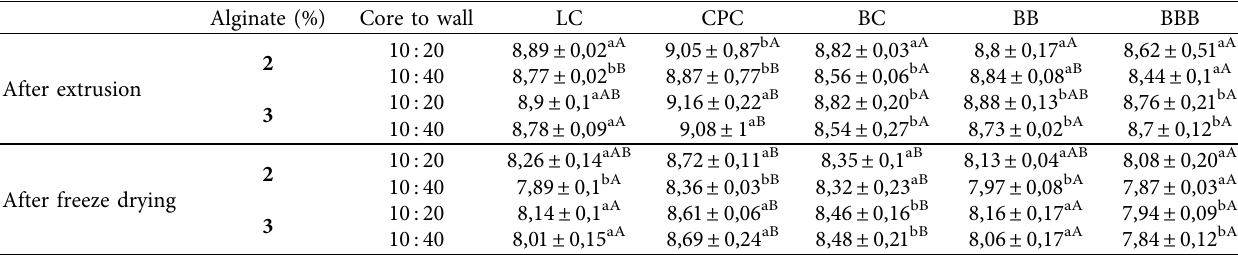
Table 7: Viability of encapsulated starter culture (cfu/gr − 1 ) after extrusion and freeze